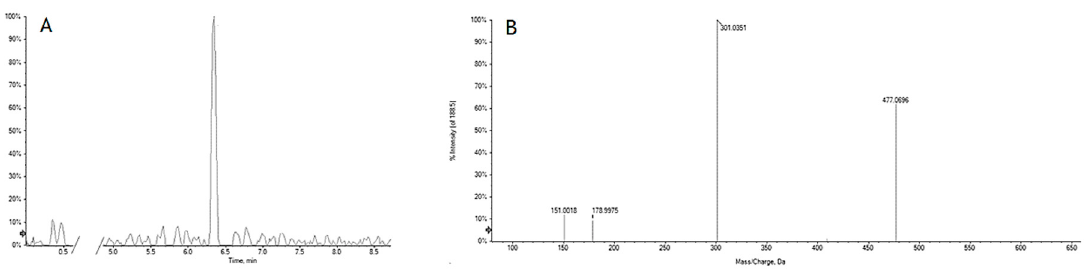
Figure 12. XIC (Extracted ion chromatogram) and TOF-MS 2 spectrum of the ion at m / z 477.0696 from cell pellet extract .